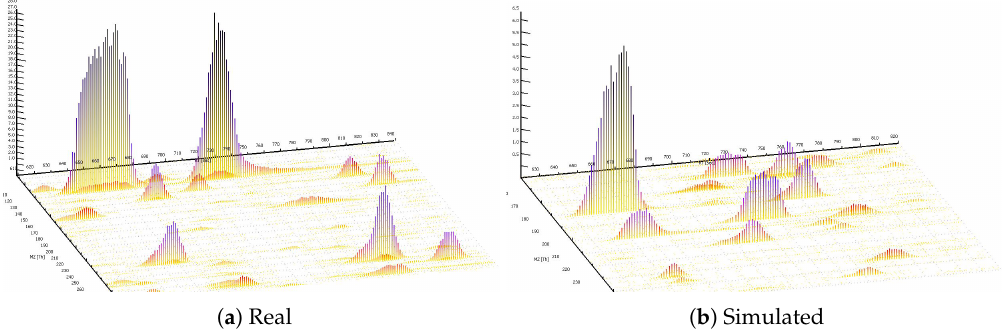
Figure 2. Real and simulated example outputs. ( a ) A region from the beer-multibeers-1 LC/MS data. ( b ) A region from an LC/MS datafile generated by randomly generating peaks (mz, RT, intensity, chromatographic shape) from a database of peaks extracted from all multi-beer data.